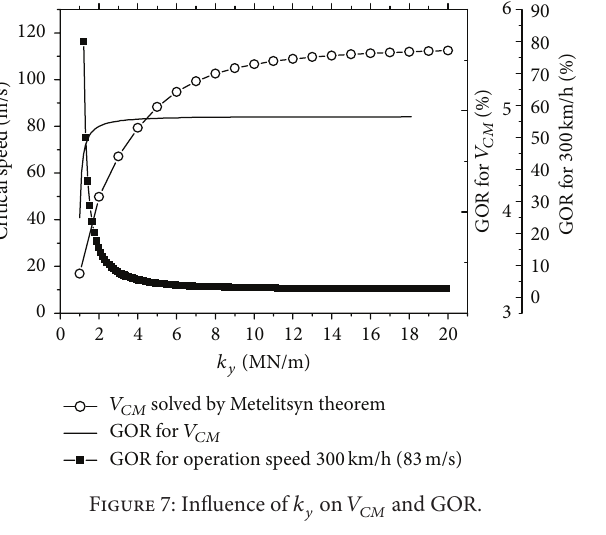
Figure 9: Influence of 𝐼 𝑦 on 𝑉 𝐶𝑀 and